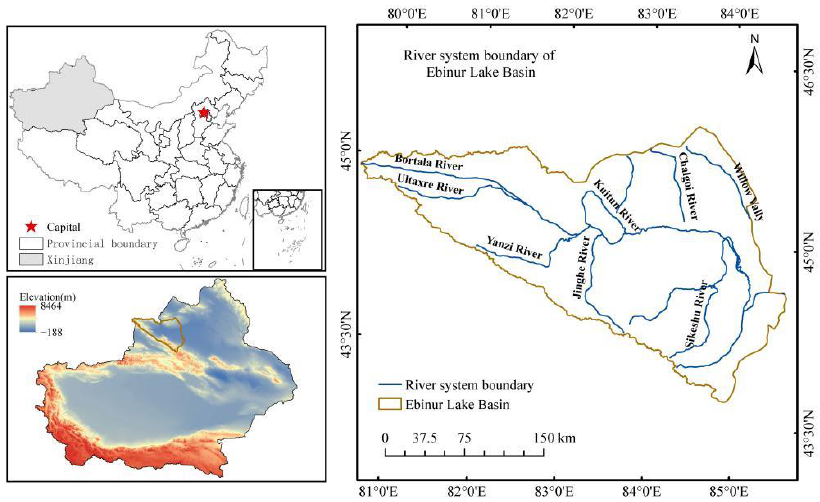
Figure 1. Schematic diagram of the Ebinur Lake Basin